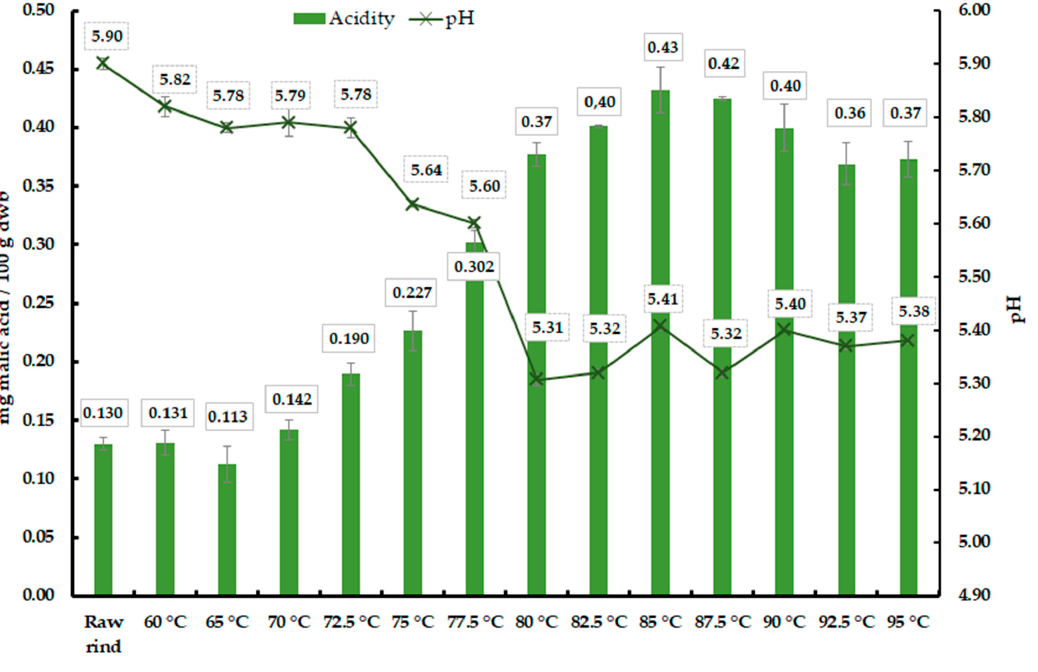
Figure 6. Acidity (mg malic acid / 100 g dwb) and pH values of the raw watermelon rind and flours obtained by convective drying at different temperatures. The technofunctional properties of flours obtained at different temperatures evalu- ated are presented in Figure 7. The results showed that the WHC and the OHC were higher for the flour obtained at 70 and 75 °C. The values of WHC and OAC were higher than those reported by Al-Sayed et al. [6] for watermelon rind dried at 50 °C, being 7.13 (g water / g) and 1.65 (g oil / g), respectively. These results indicate that between 70 and 75 °C watermelon rind flour holds more water and oil compared to rinds dried at 50 °C.